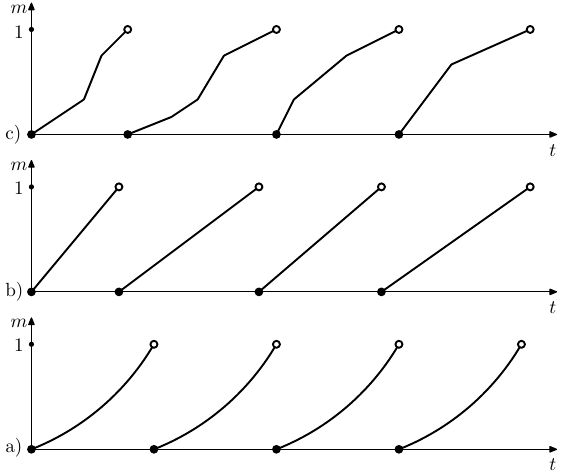
Fig. 2. Sample graphs of maturity in the models: a) Rubinow, b) Lebowitz-Rubinow, c)